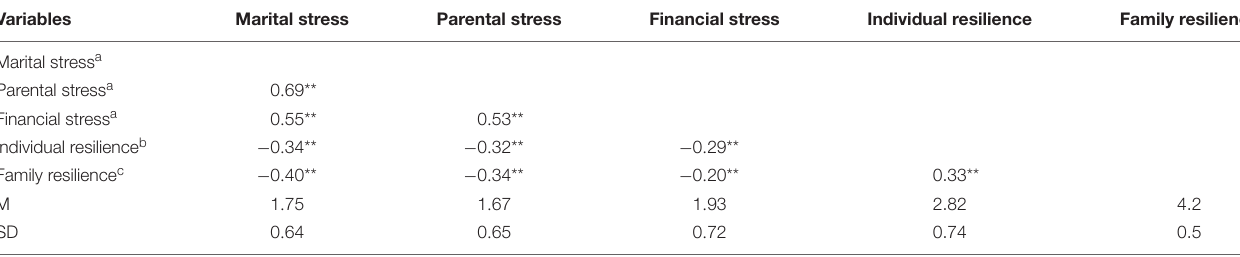
TABLE 2 | Resilience factors and stress measures: correlations and descriptive statistics ( N = 480).